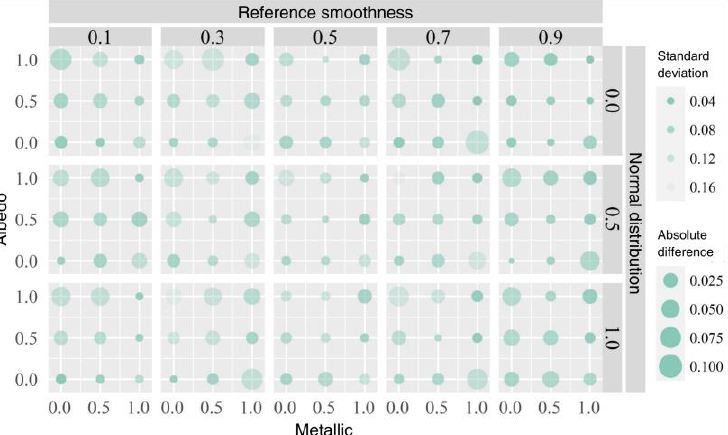
Figure 6. The results of differential distribution. The opacity of the circular data points in the figure indicates the standard deviation of the perceived differences under the current parameter combination. A higher opacity indicates a larger degree of discrepancy in the perceived differences at the corresponding point. The radius of each circular data point represents the absolute value of the smoothness difference, with a larger radius indicating a larger absolute value of the difference.